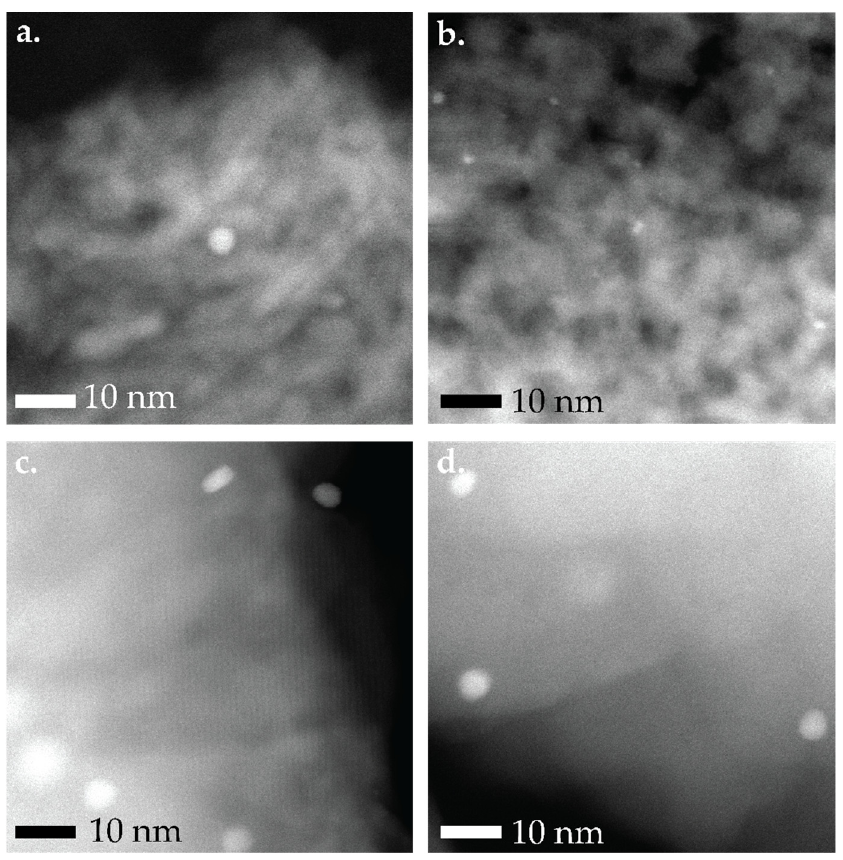
Figure 9 . Representative HAADF-STEM images of ( a ) Au/TiO 2 - γ -Al 2 O 3 , ( b ) Au/TiO 2 -SiO 2 , ( c ) Au/TS-1, ( d ) Au/TS-1U. Table 3. Characteristics of the as prepared Au catalysts.